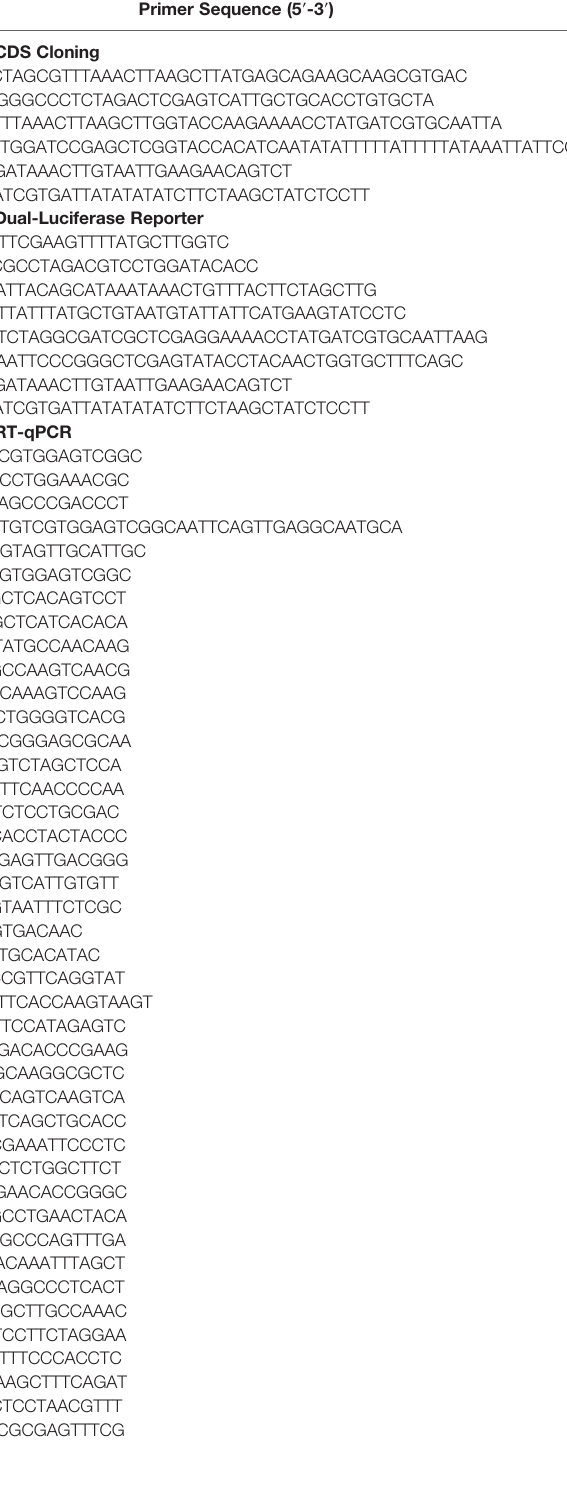
TABLE 1 | Sequences of DNA